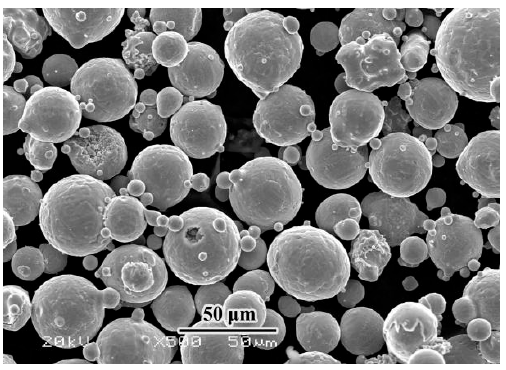
Figure 1. The morphology of 24CrNiMo alloy steel powder. Table 1. Particle size distribution of 24CrNiMo alloy steel powder.